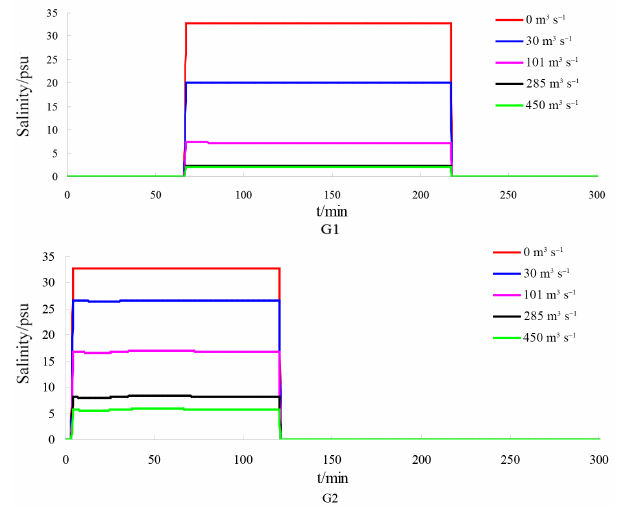
Figure 19. Simulated salinity under different runoff